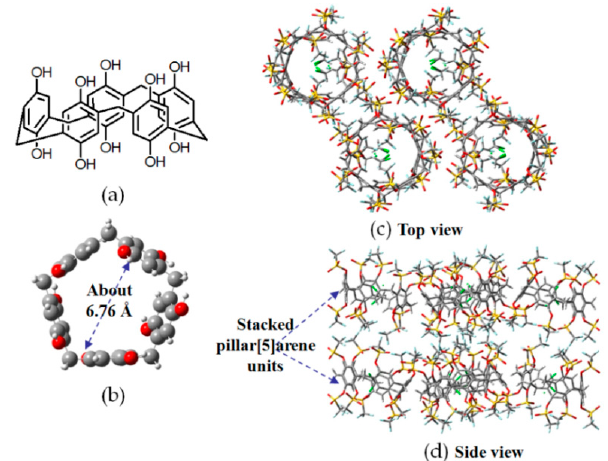
Figure 12. ( a ) Structure of the building motif of H11 ; ( b ) Pentagonal cavity of pillar[5]arene; ( c , d ) Top view and side view of crystalline network of H11 .